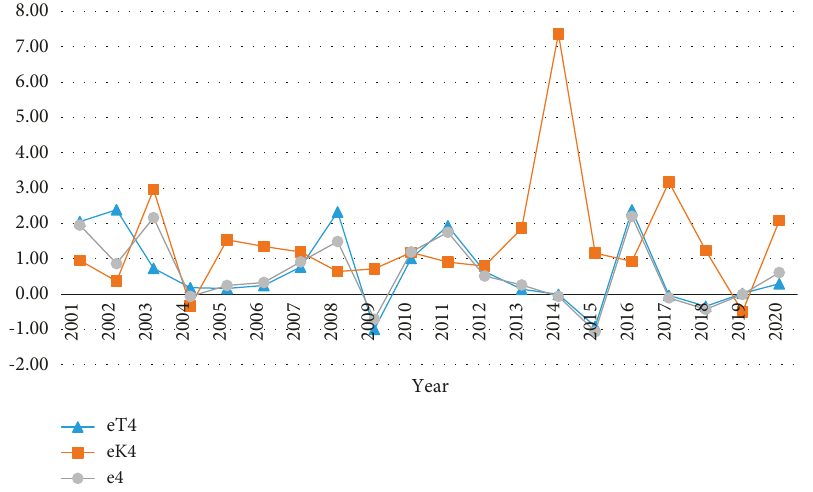
Figure 19: Relationship between carbon emission decoupling index and intermediate variables of the nonferrous metal sector from 2001 to